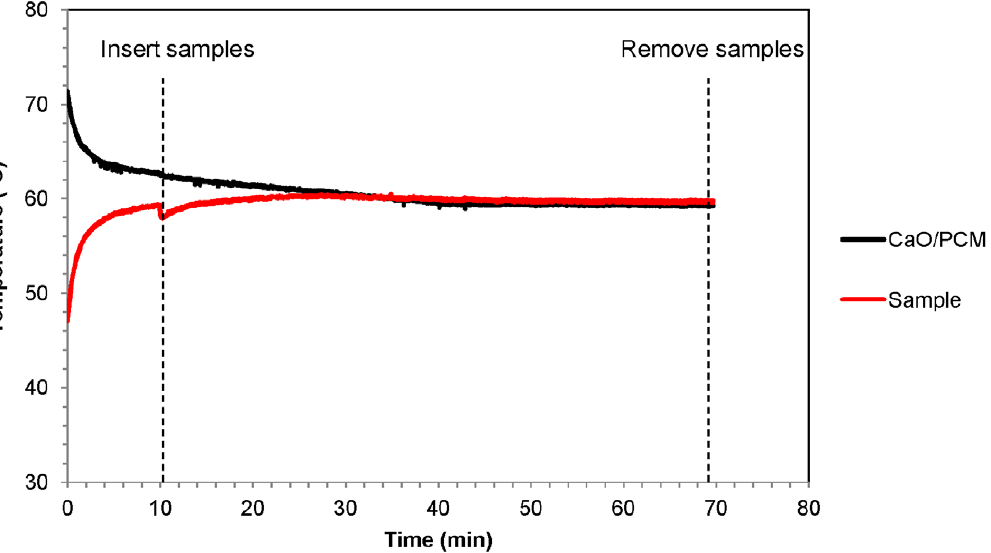
Figure 2. Representative temperature profile of RT-LAMP reaction in NINA heater. The temperature of the reaction tube and phase change material (PCM) was recorded for a 60 minute RT-LAMP reaction using the DaqPRO 5300. Temperature recording was initiated following addition of water to the CaO and terminated upon sample removal. doi:10.1371/journal.pone.0031432.g002 PLoS ONE |